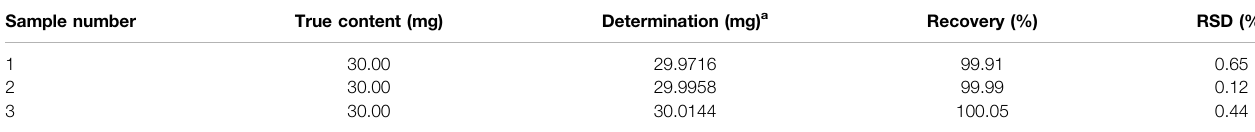
TABLE 4 | Application of CV method in determination of Taxol. Sample